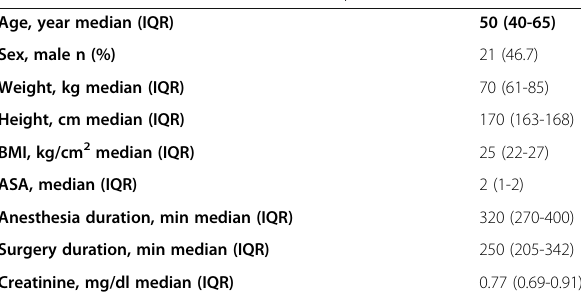
Table 1 (abstract A23). See text for